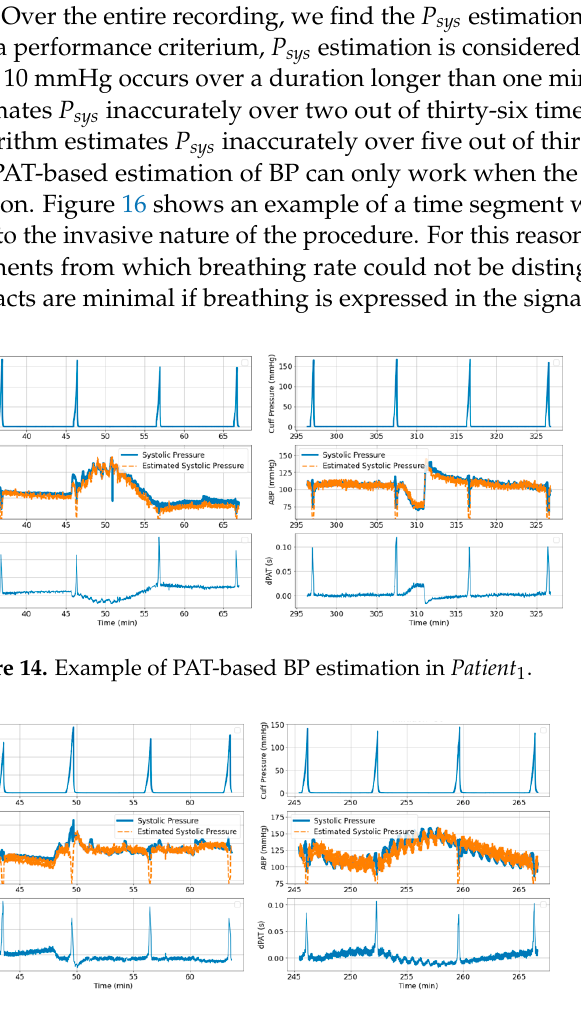
Figure 15. Example of PAT-based BP estimation in Patient 2 .